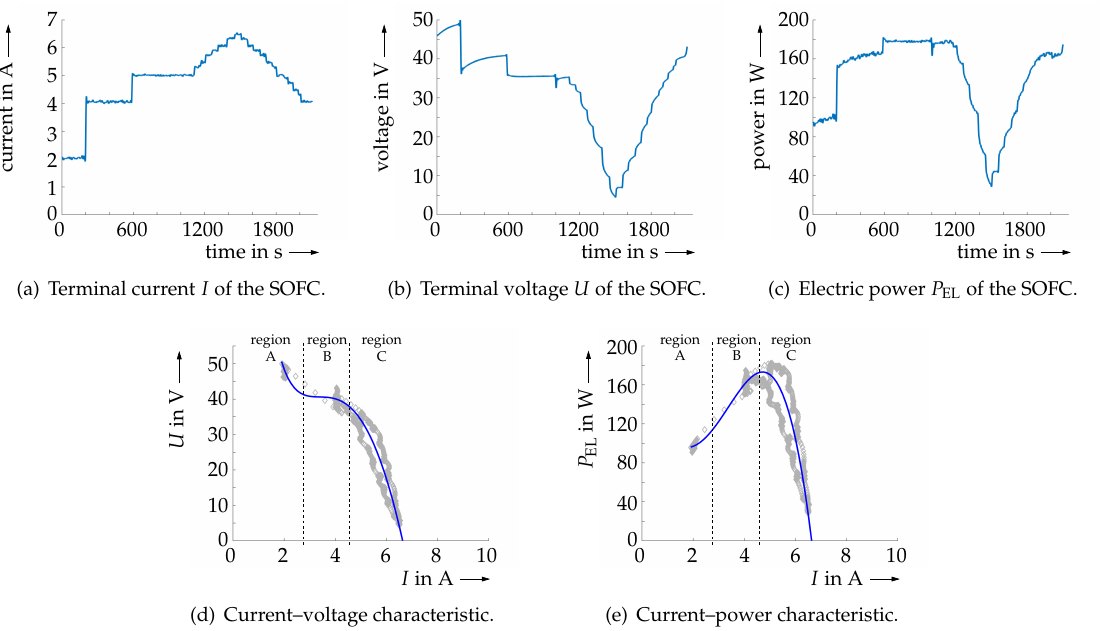
Figure 5. Measured electric current I , terminal voltage U , and electric power P EL of the SOFC for a relatively small, constant hydrogen mass flow ˙ m H